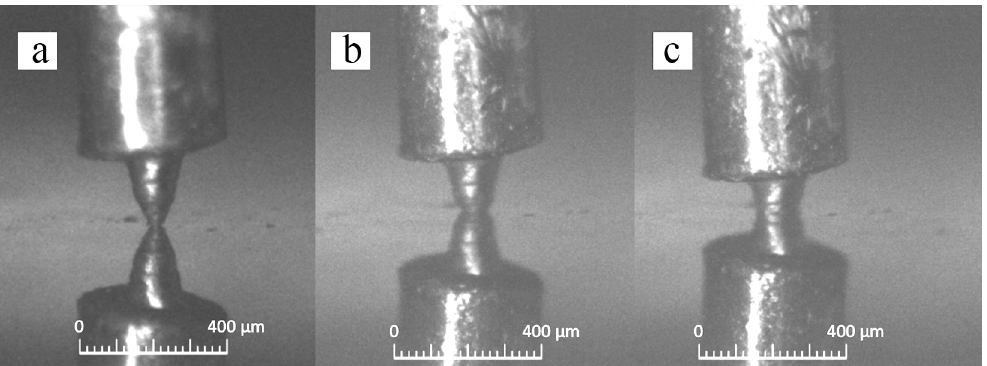
Figure 7. Various variants of the liquid electrode contact area: ( a )—contact area diameter d = 40 µm; ( b )—contact area diameter d = 80 µm; ( c )—diameter of the contact area d = 120 µm.